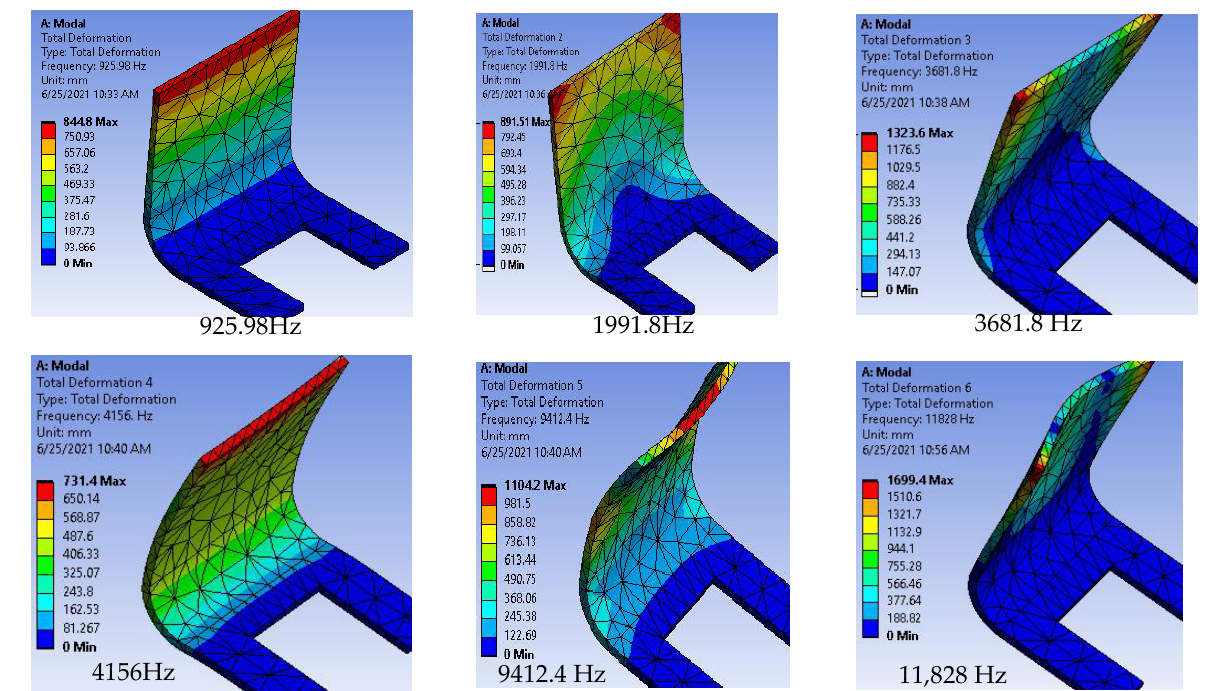
Figure 5. Eigenvalues and eigenvector of the bracket.